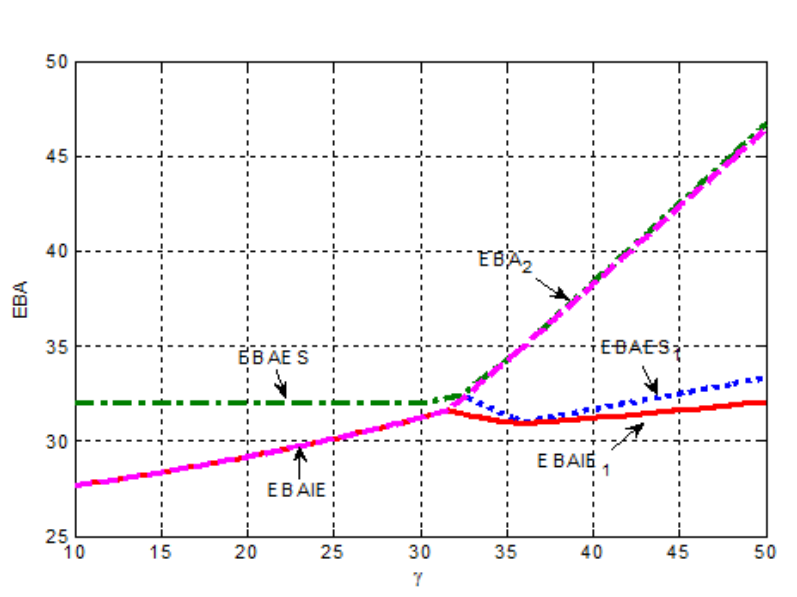
Figure 3. EBA dynamics with based on different risk